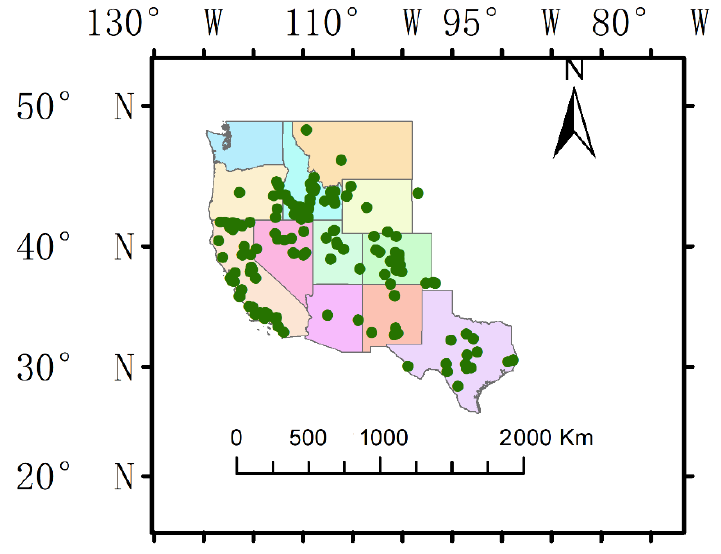
Figure 1. Geographical location of study area and sample point distribution.